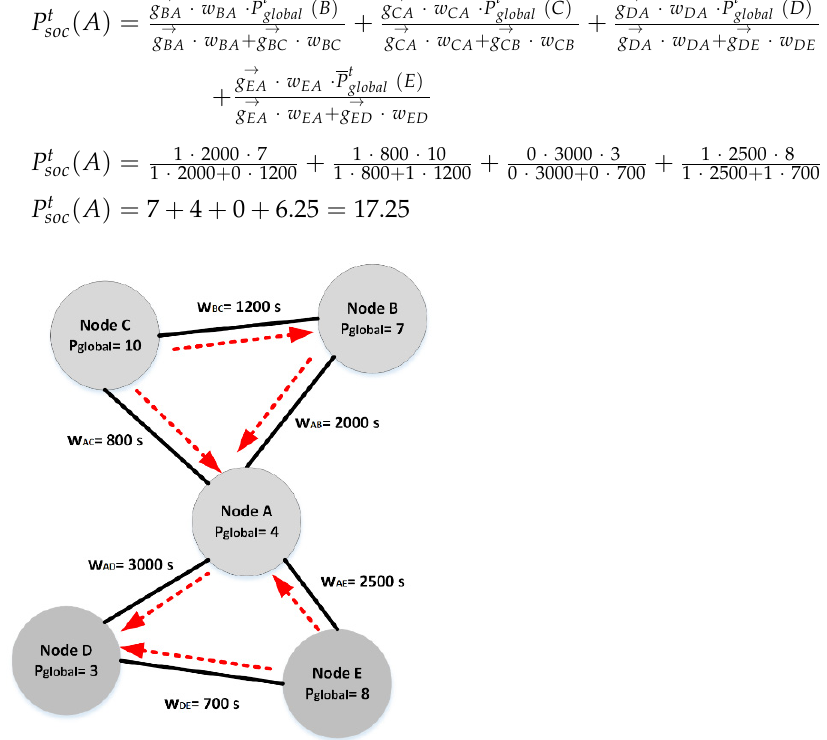
Figure 6. A neighbourhood of node A , comprising four nodes which gives social influences to node A . Social influences (red dotted vectors) to node A exist when the global popularity of the neighbours is higher than A’s.